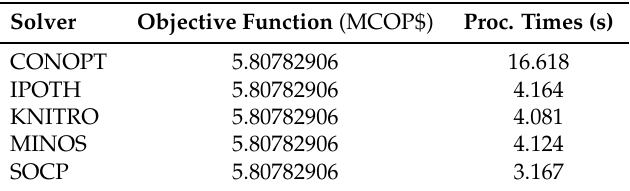
Table 5. GAMS solutions for the simulation C 1 .